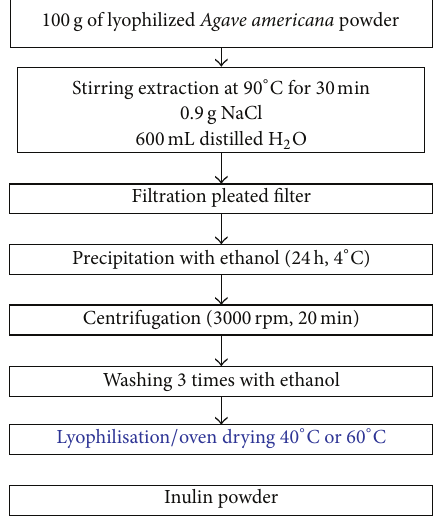
Figure 1: Extraction diagram of inulin from Agave americana